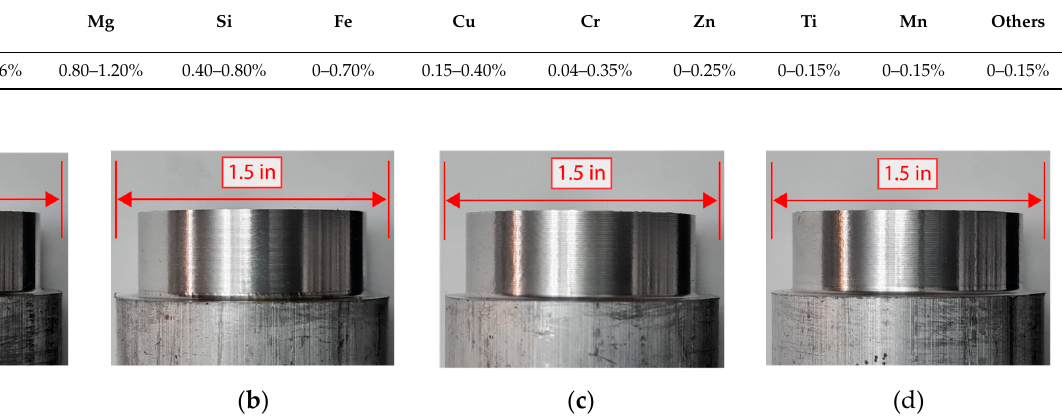
Figure 4. Aluminum bars used for the experiments: ( a ) bar machined for the cutting speed test using the tool with no wear; ( b ) piece machined for the cutting speed test with the tool with the largest wear; ( c ) part machined for the feed rate test with the tool with no wear; ( d ) workpiece machined for the feed rate test with the tool presenting the greatest wear.